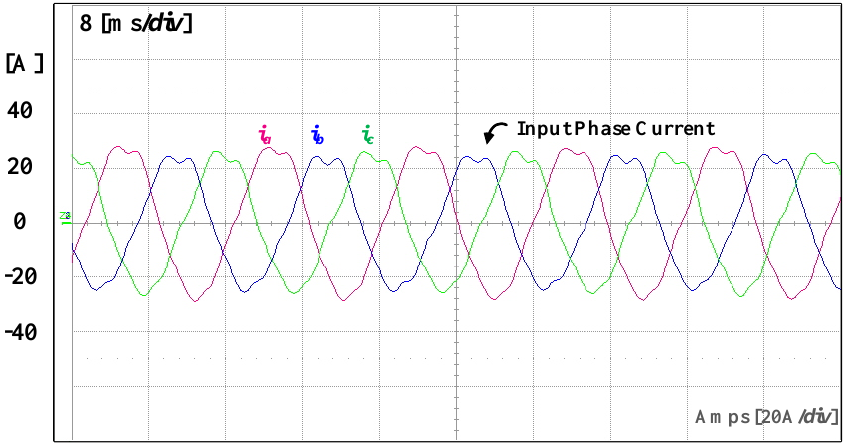
Figure 26. Waveform of input phase current of 3-phase AC/DC PWM converter.